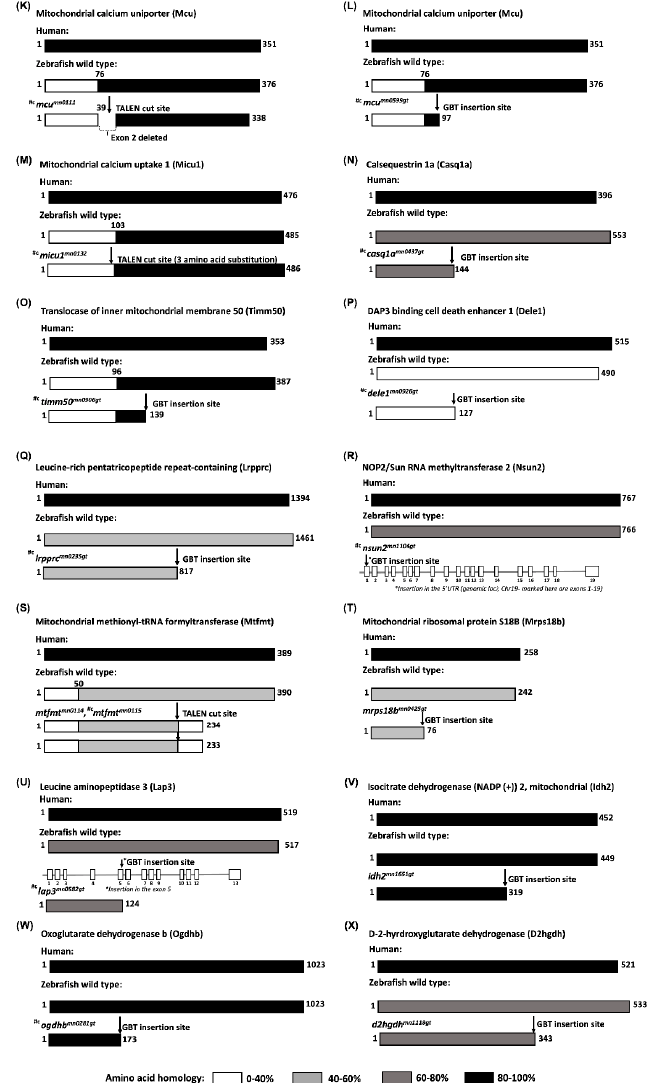
Figure 3. A depiction of homology of the mutants created for proteins involved in different mitochondrial resident pathways: ( A – B ): Complex 1 of mitochondrial respiratory chain; ( A ): NADH: ubiquinone oxidoreductase complex assembly factor 6 (Ndufaf6); ( B ): NADH: ubiquinone